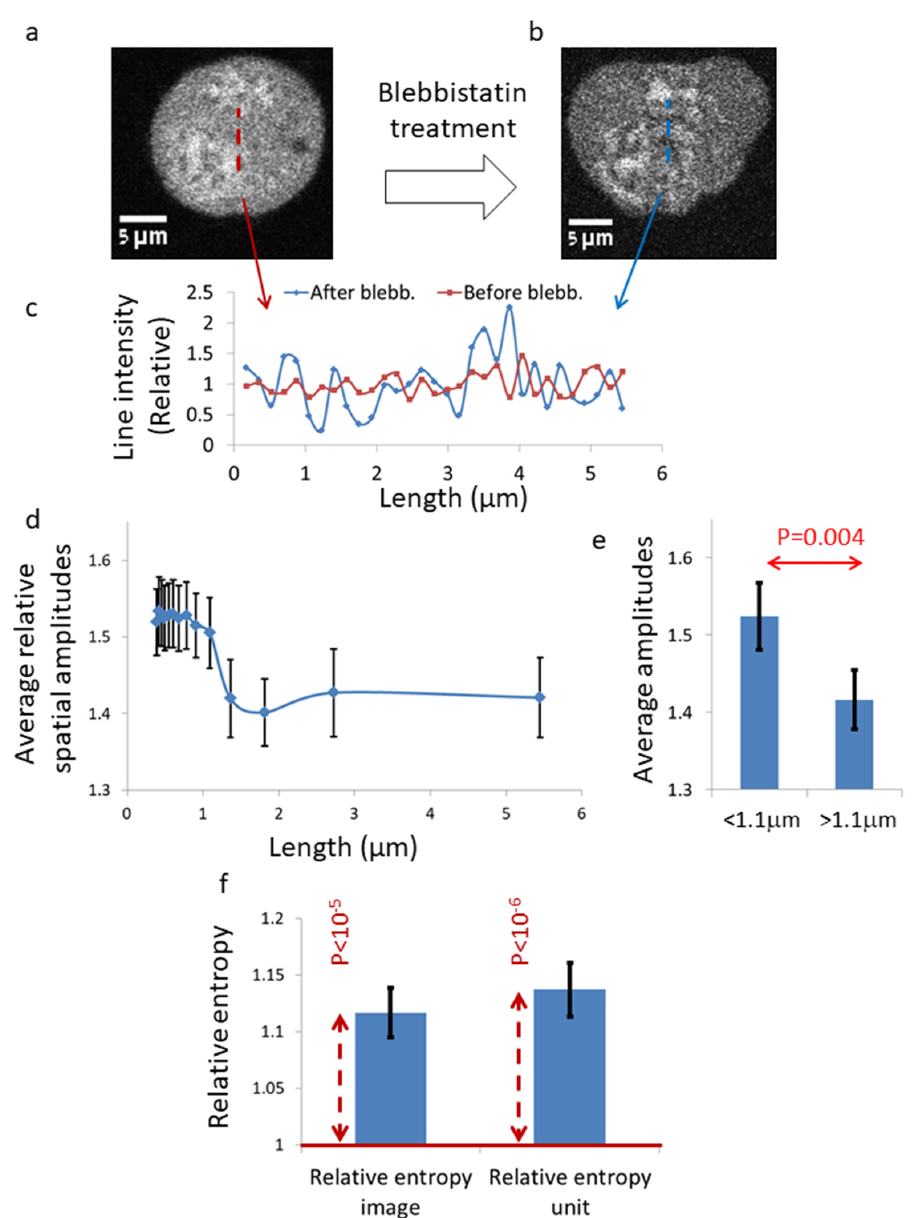
Figure 1. Spatial DFT analysis of Ca ++ -Fluo-4 in live T cells before and after blebbistatin treatment. ( a ) An image of Ca ++ -Fluo-4-highlighted, untreated T cell. ( b ) An image of the Ca ++ -Fluo-4-highlighted cell after 10 µ M blebbistatin treatment. ( c ) Line scans of the relative light intensities [the pixels intensity divided by the average region of interest (ROI) intensity] in a line of 30 pixels, as illustrated in the corresponding image. ( d ) The average spectrum of the relative spatial amplitudes (i.e., the spatial amplitudes in a cell after blebbistatin treatment, divided by the corresponding amplitudes in the same cell before blebbistatin treatment) in all cells (N = 31). ( e ) The average relative amplitudes at spatial length scale < 1.1 μ m in comparison to the average relative amplitudes at spatial length scale > 1.1 μ m. ( f ) The average relative pixels’ information entropy (the pixels’ information entropy in a cell after blebbistatin treatment, divided by the pixels’ information entropy in the same cell before blebbistatin treatment) in all cells (N = 31). The pixels’ information entropy was calculated in two ways: first for all the ROI pixels’ values, and second by dividing the ROI to 36 units of 5 × 5 pixels and then averaging the pixels’ information entropy results of all units of a ROI. The red dotted arrows illustrate the difference in the average relative entropy values from a value of 1 (representing the null hypothesis). Error bars are SEM and p -values are shown in ( c , d ).